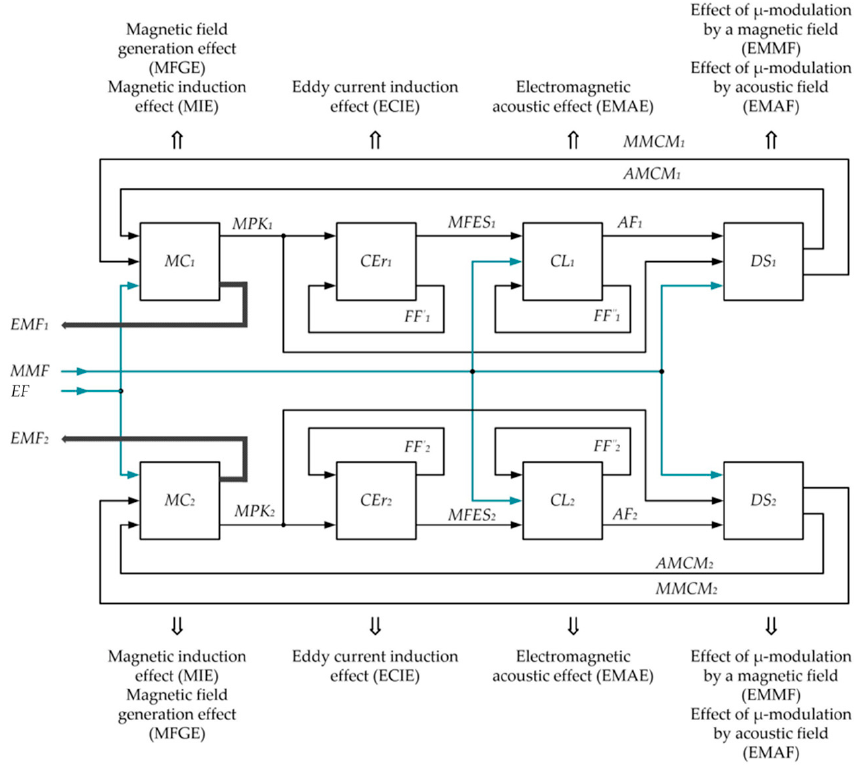
Figure 7. The FS Physical Diagram. In Figure 7: MC 1 and MC 2 are measuring coils of, respectively, FC-I and FC-II; CEr1 and CEr2 are conduction electrons of the ferromagnetic material of, respectively, the core elements FC-I and FC-II; CL 1 and CL 2 are crystal lattices of the material of, respectively, the core elements FC-I and FC-II; DS 1 and DS 2 are domain systems of the material of, respectively, the core elements FC-I and FC-II; EMF 1 and EMF 2 are electromotive